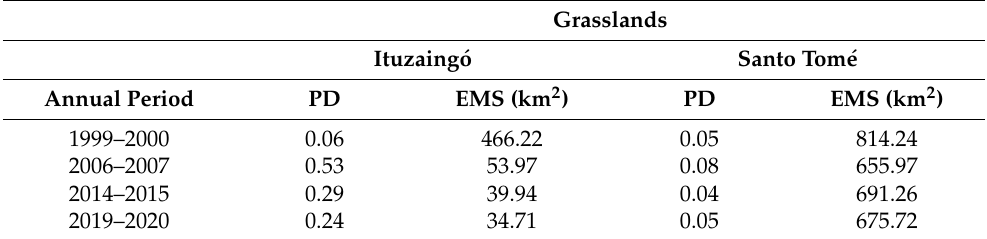
Table 6. Grassland landscape metrics at class level (PD, EMS) for the Aguapey VGA districts. Grasslands Ituzaing